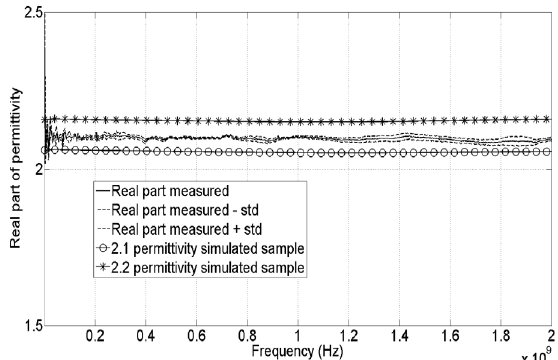
Figure 9. Real part of the permittivity of Teflon measured and simulated with core radius a = 6.5 mm.